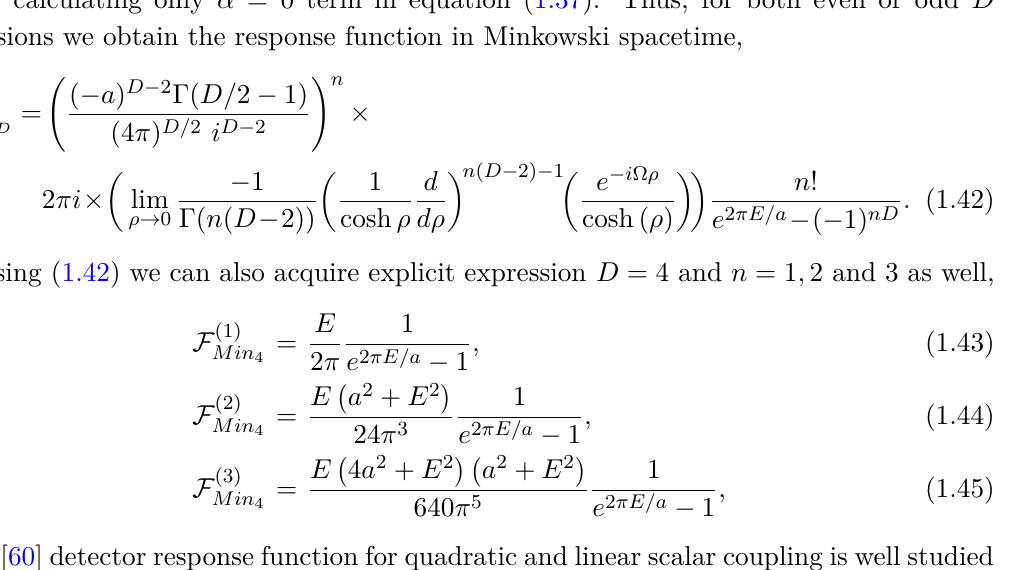
as function of (c) energy 4